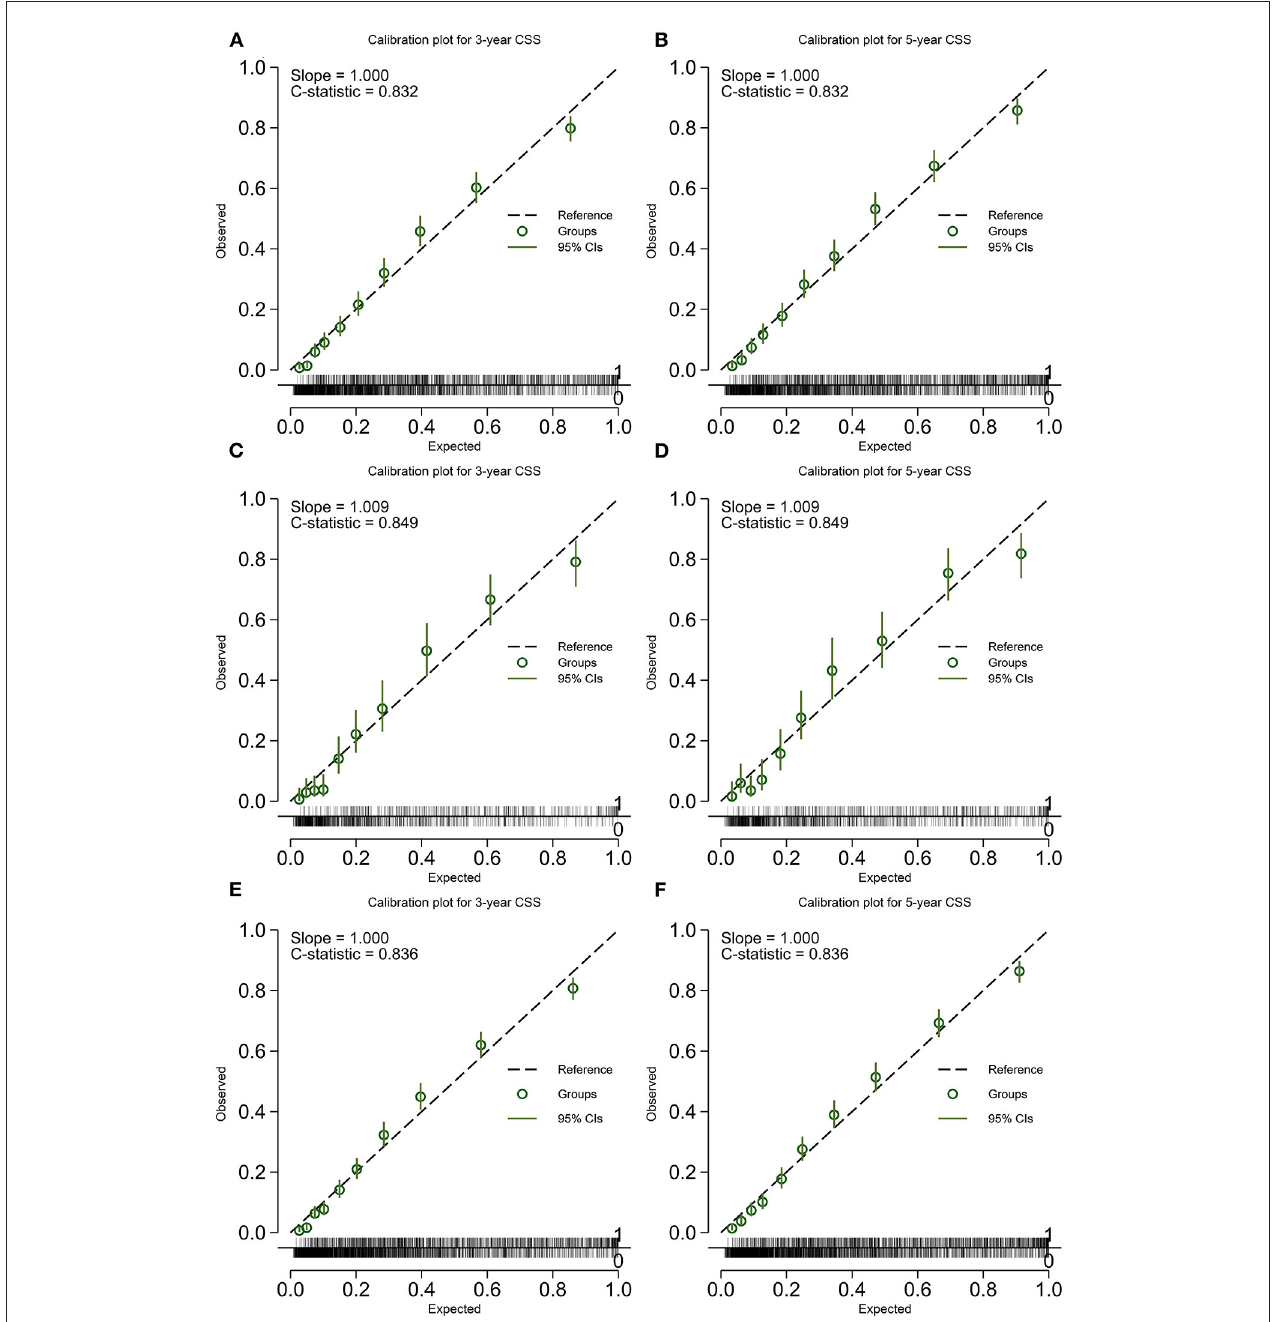
FIGURE 5 | Calibration plot of the model predicting CSS. (A) 3-years CSS in the training cohort; (B) 5-years CSS in the training cohort; (C) 3-years CSS in the validation cohort; (D) 5-years CSS in the validation cohort; (E) 3-years CSS in the overall cohort; and (F) 5-years CSS in the overall cohort. CSS, cancer-specific